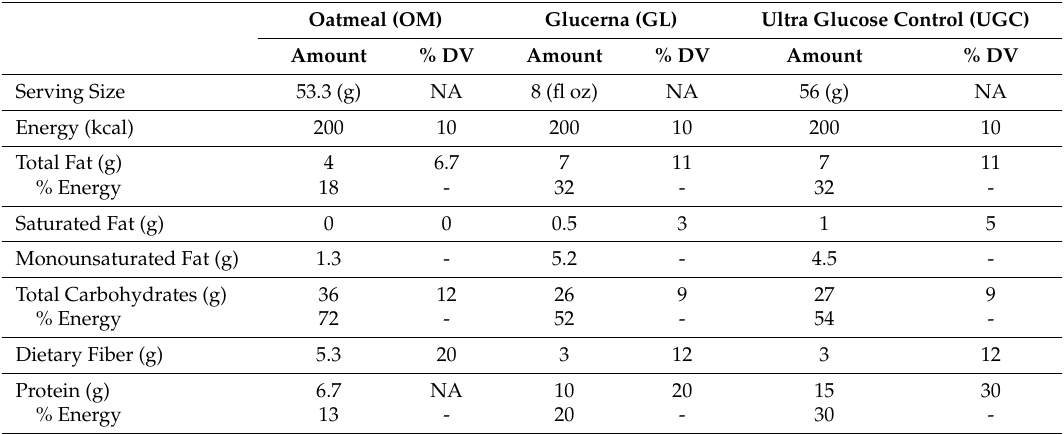
Table 2. Nutrition information of the three breakfast meals.